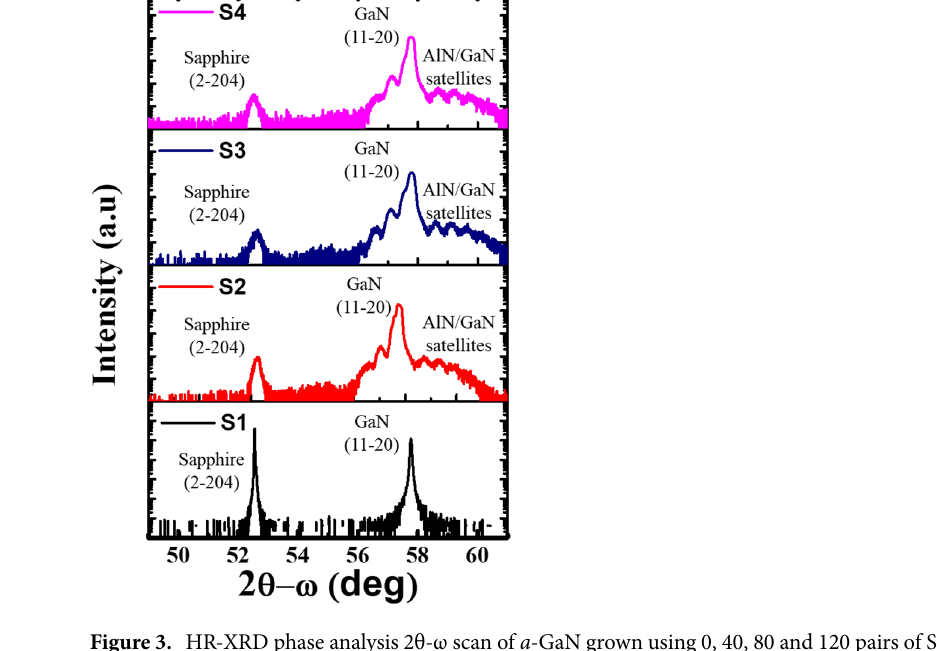
Figure 3. HR-XRD phase analysis 2θ-ω scan of a -GaN grown using 0, 40, 80 and 120 pairs of SSPM-L AlN/ GaN.